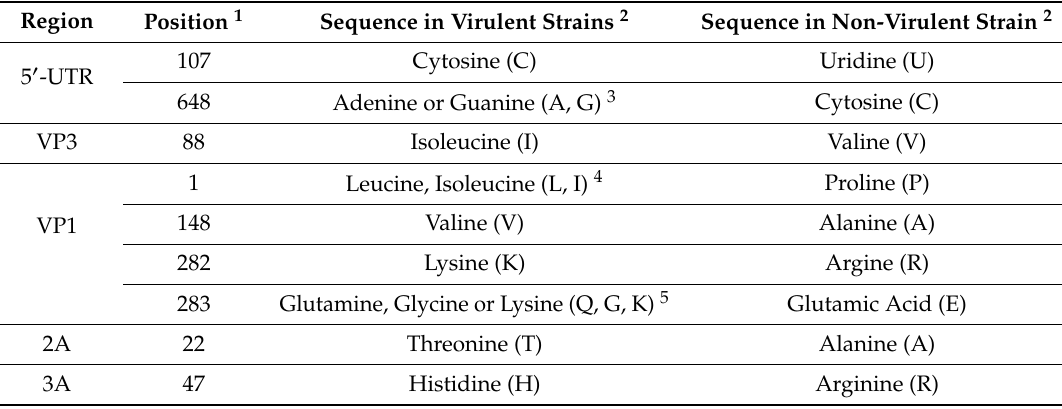
Table 2. Conserved nucleotide and amino acid di ff erences in virulent and non-virulent EV-D68